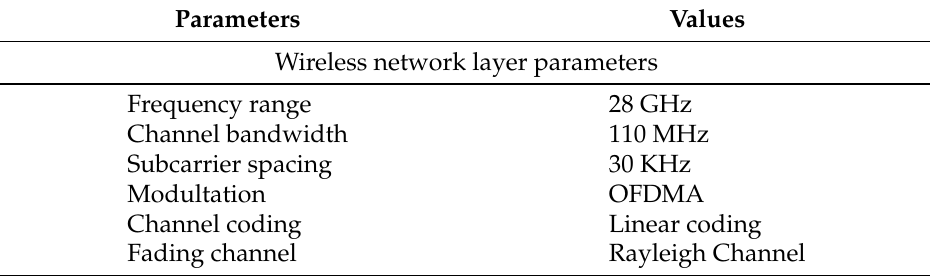
Table 2. Simulation parameters of the proposed